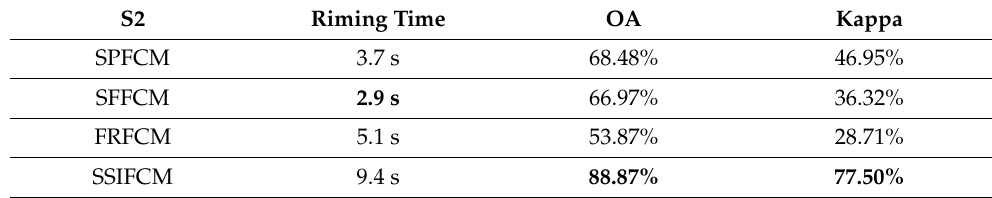
Table 10. Comparison of the running time of SSIFCM with SPFCM, SFFCM, and FRFCM.